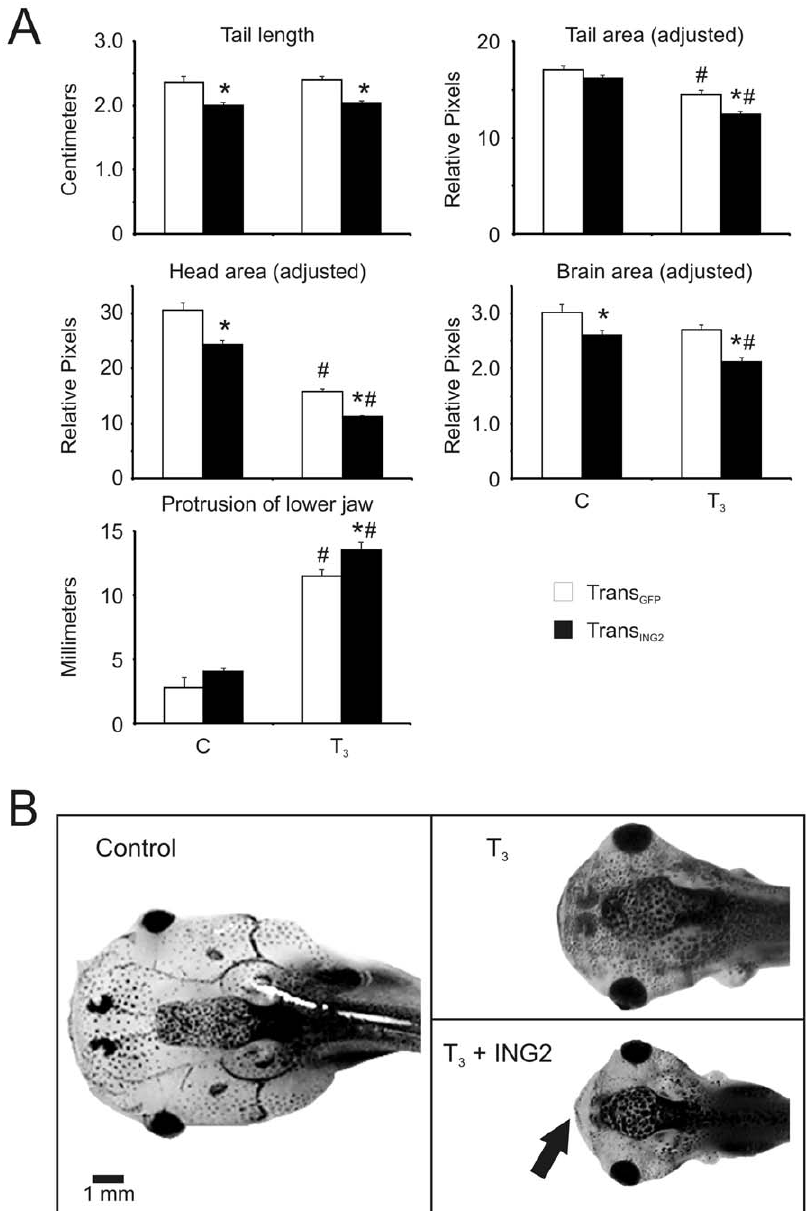
Figure 2. ING2 overexpression influences tadpole morphology upon T 3 exposure. A) Comparison of morphological responses to T 3 exposures of ING2 -overexpressing tadpoles (Trans ING2 , black bars; n=20) and transgenic tadpoles expressing GFP only (Trans GFP , white bars; n=10). Vehicle control animals (C) are compared with tadpoles treated with 10 nM T 3 for 5 days (T 3 ). The asterisk denotes a significant difference between the Trans ING2 and the Trans GFP transgenic animals (ANOVA, p , 0.04; brain area: Mann Whitney U, p=0.033). The ‘‘ # ’’ indicates statistical significance relative to the vehicle control within a transgenic type. The error bars represent the standard error of the mean. ‘‘Adjusted’’ data were corrected for the differences in body sizes by dividing the area values by the tail lengths before analysis of T 3 -dependent effects. B) Dorsal view of representative X. laevis tadpoles that were exposed to vehicle control (‘‘C’’) or T 3 for 5 days. The black arrow indicates a more prominent protrusion of the lower jaw in the Trans ING2 animals compared to Trans GFP transgenic animals.